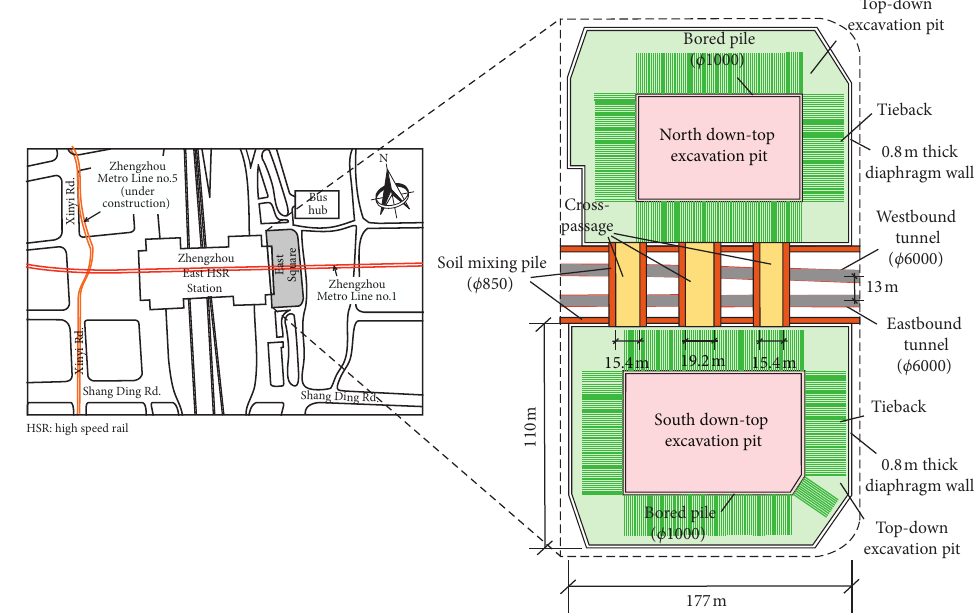
Figure 4: Location layout of the foundation pit.